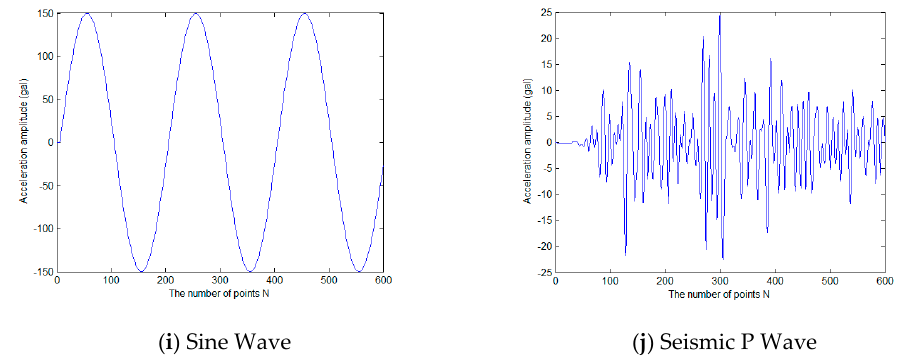
Figure 16. Examples of Various Types of Noise Interference Waveforms.